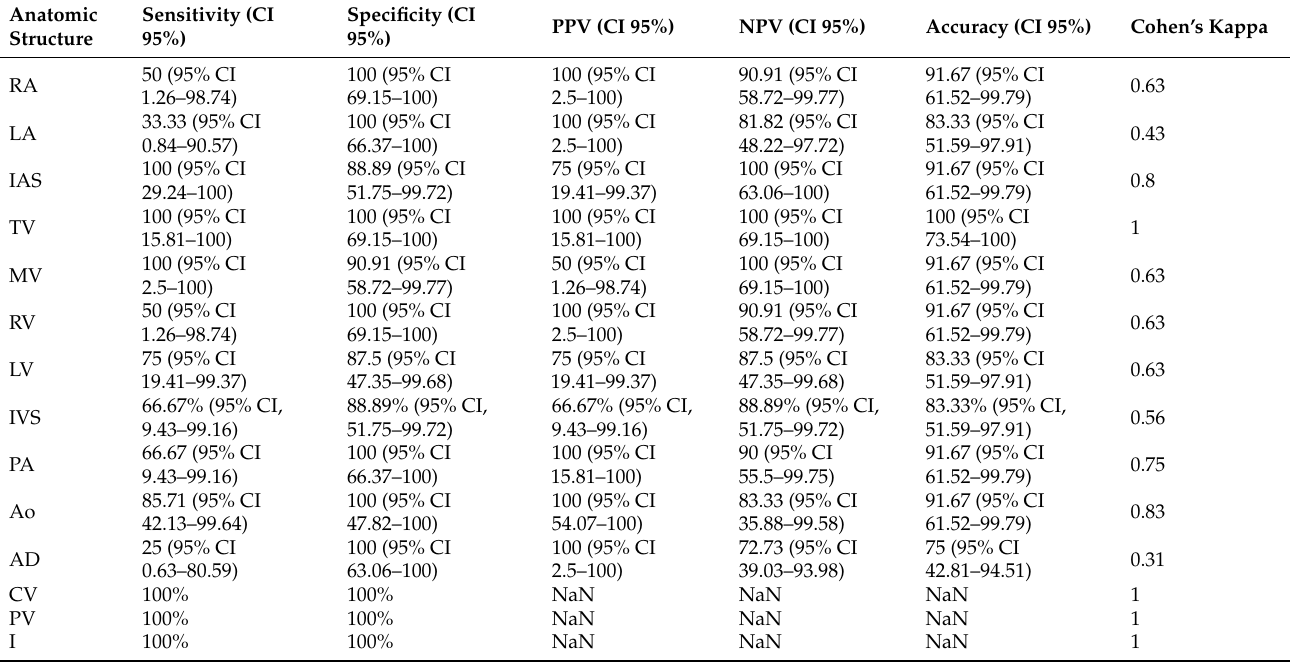
Table 2. Showing the analysis of the effectiveness of the four-chamber cardiac dissection method in diagnosing fetal cardiac anomalies compared to pm-MRI for each examined